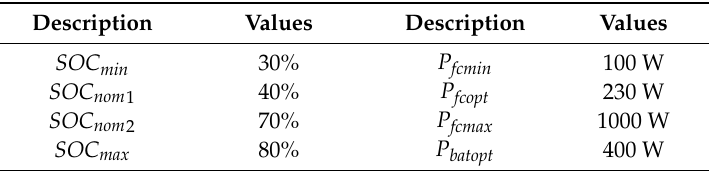
Table 3. Control parameters of the energy management